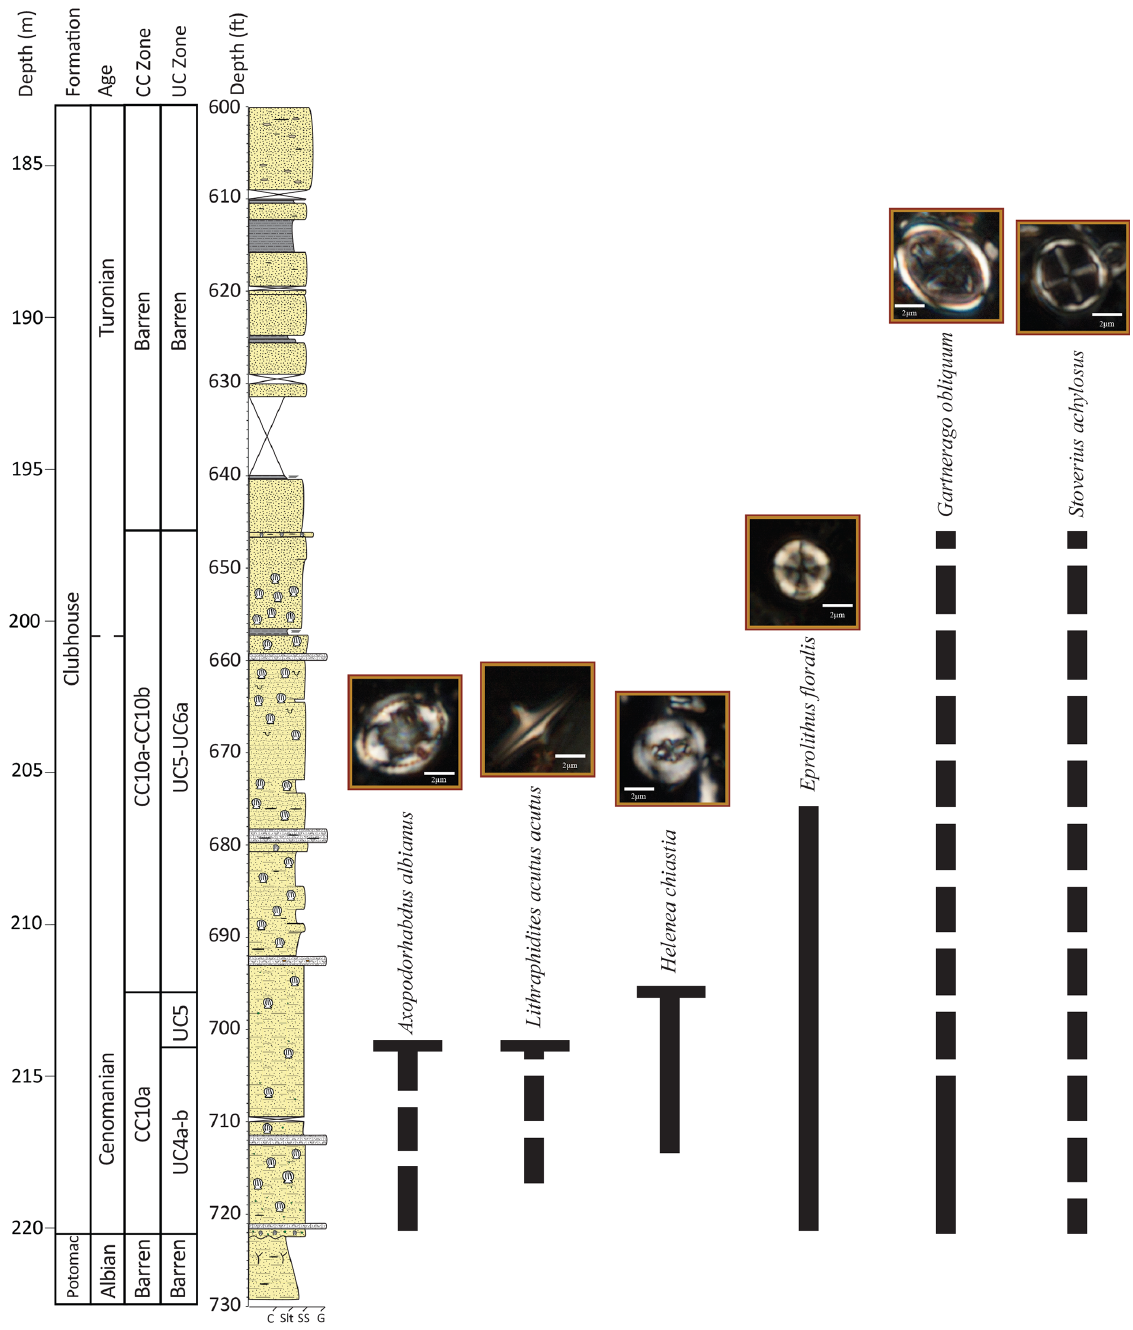
Figure 4. Ranges of key calcareous nannoplankton species in the Hope Plantation core. Dashed lines indicate sporadic